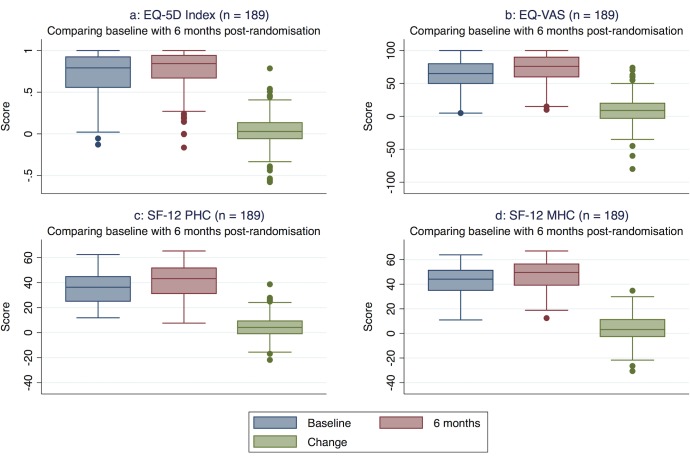
a-d. Boxplots health realated quality of life scores at baseline and 6 months after randomisation including change scores (with quartiles and extreme scores) (n = 189). VAS, Visual Analogue Scale; PHC, Physical Health Composite score; MHC, Mental Health Composite score.